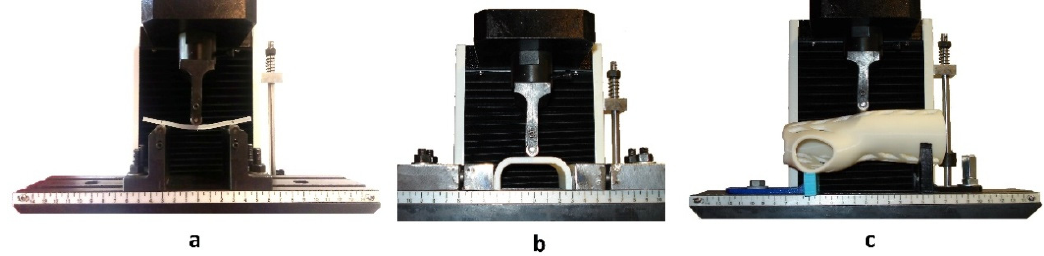
Figure 4. Three-point bending of the sample: view of the working tooling of the testing machine, bending of the sample: ( a ) basic, ( b ) in the shape of the central part of the orthosis, ( c ) in the shape of an orthosis.